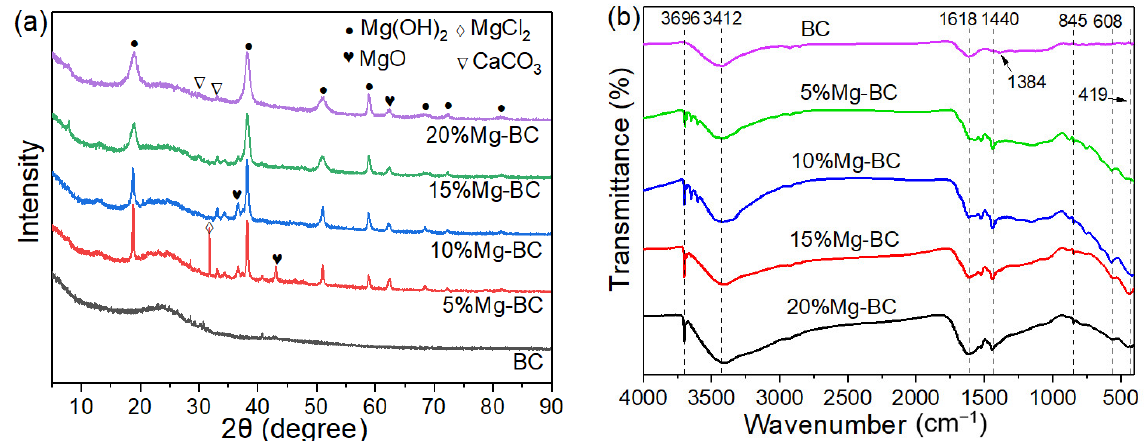
Figure 2. X-ray diffraction patterns ( a ) and Fourier transform infrared spectroscopy (FTIR) transmission spectra ( b ) of biochars.